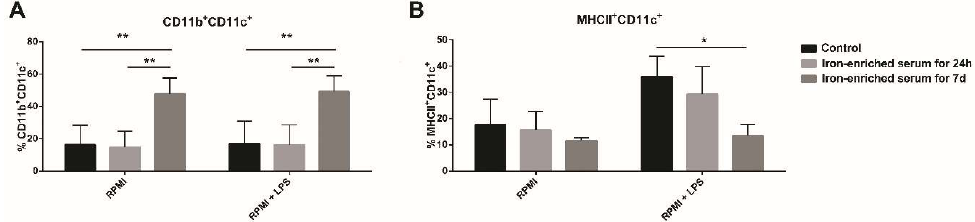
Figure 5. Diagrams representing the percentages of CD11c + CD11b + cells ( A ) and CD11c + MHCII + cells 24 h after LPS exposure ( B ). * p < 0.05 ** p < 0.01.